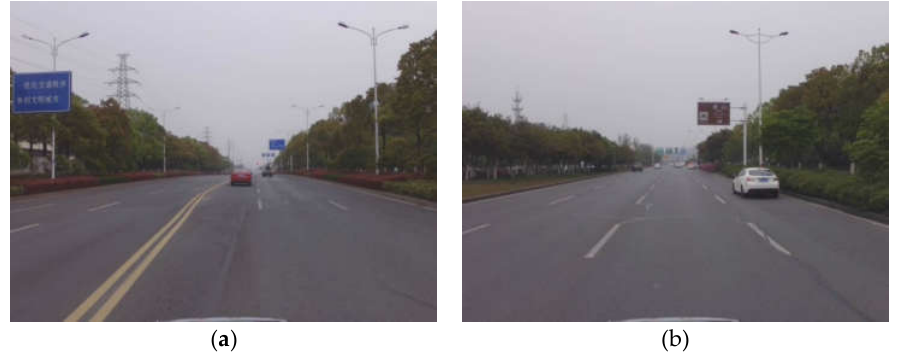
Figure 21. Test site at sunset: ( a ) site 1; ( b ) site 2. Table 5. Results of the comparative experiments at sunset.